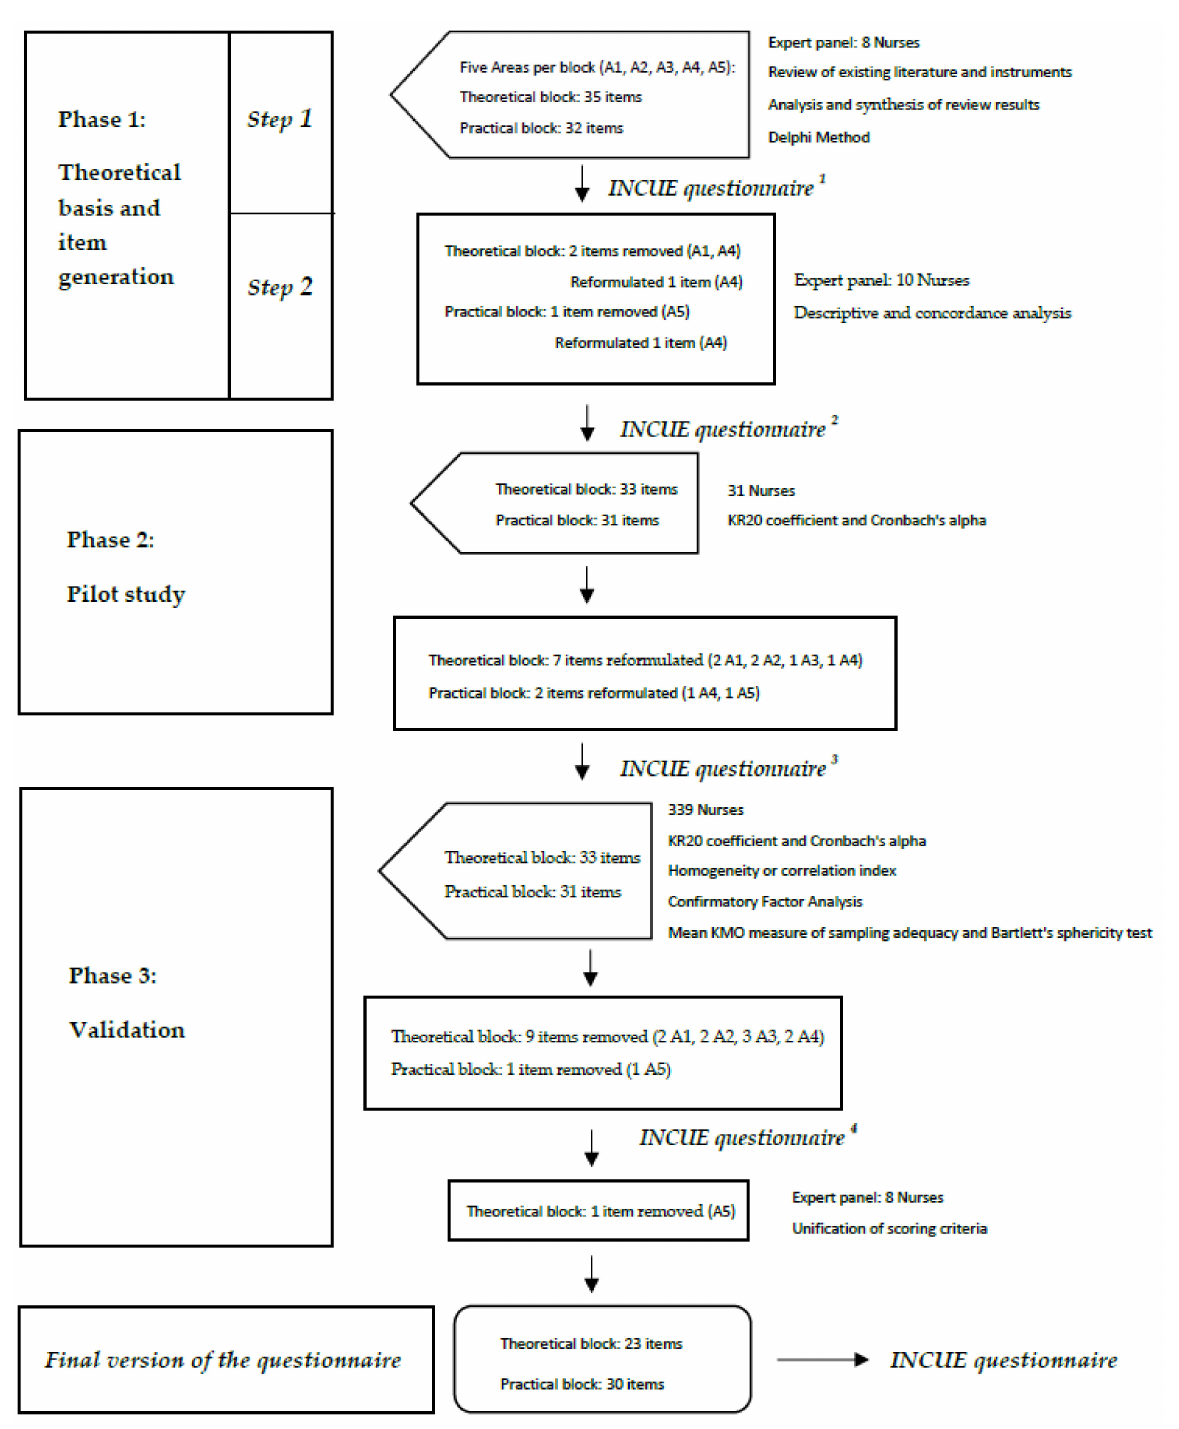
Figure 1. Investigaci ó n Cuidados Enfermeros/Investigation into Nurses’ Care Understanding of End-of-Life (INCUE) questionnaire developmental